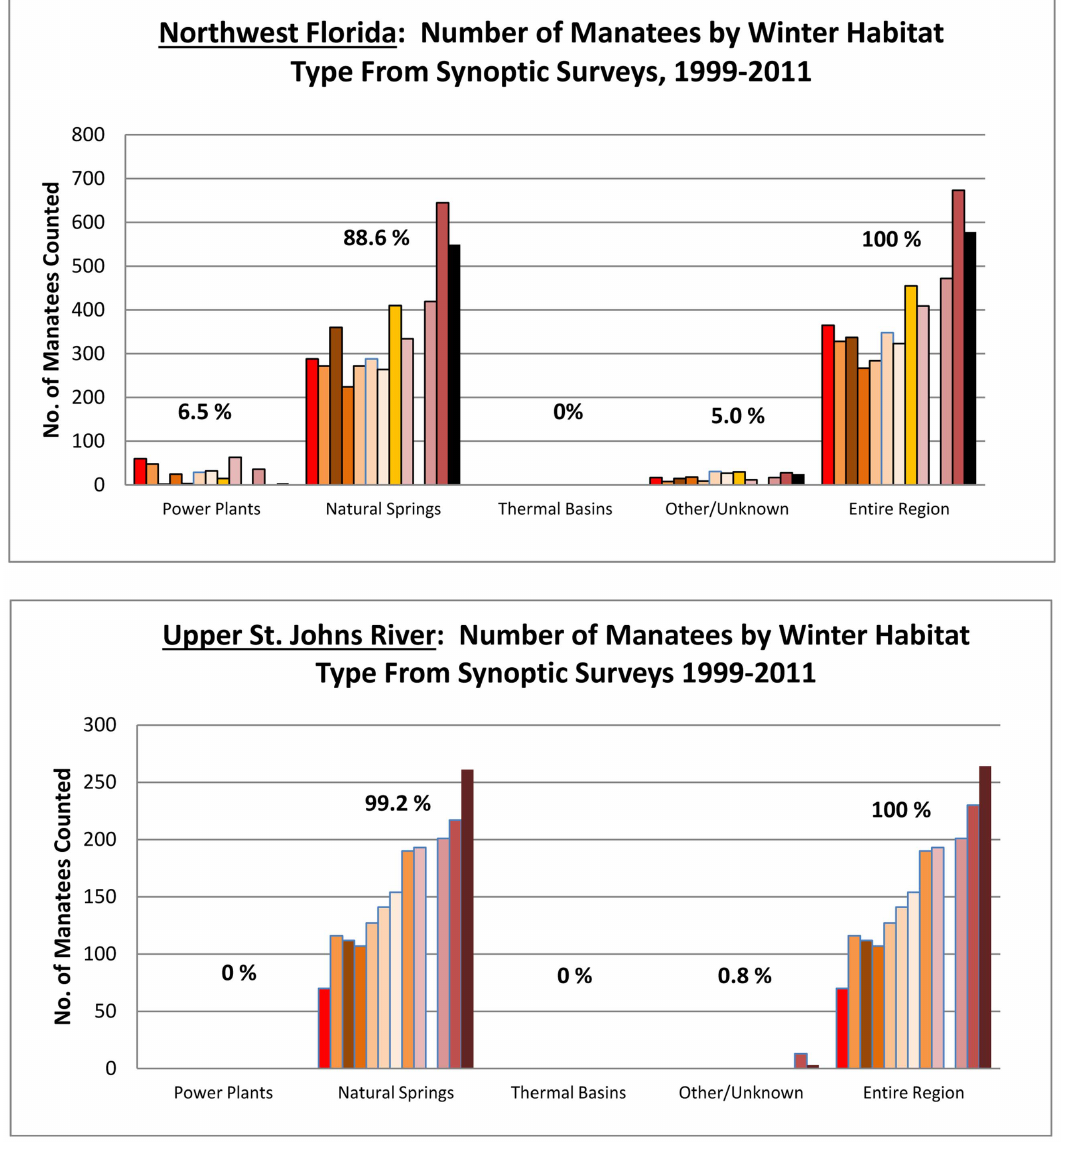
Figure 4. Proportions of manatees in the upper St. Johns River and Northwest Florida subpopulations at power plants, natural springs, thermal basins, and other sites during synoptic surveys from 1999 to 2011. (Bars indicate the number of manatees counted each year over the 13-year study period; no survey was conducted in 2008.)